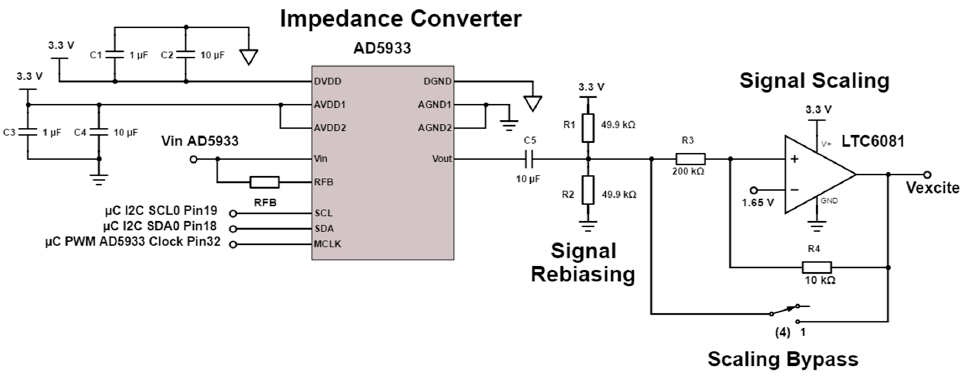
Figure 4. Circuit schematic of the AD5933 impedance analysis chip and signal scaling stage. Table 2. Excitation voltage amplitudes and DC bias levels for a supply voltage of 3.3 V [24].